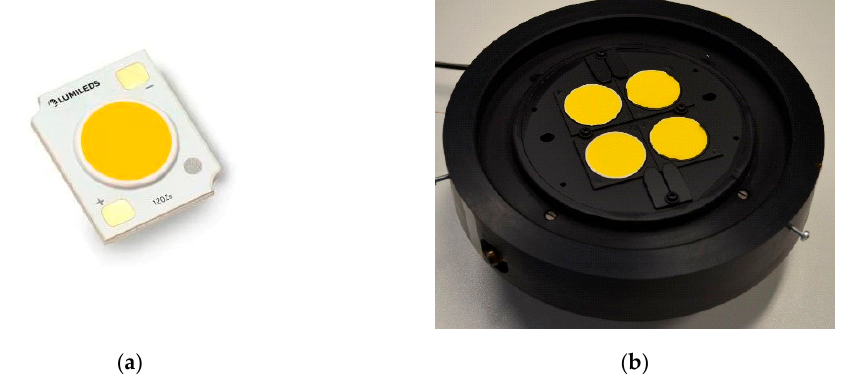
Figure 6. Commercially available CoB LED devices in their unpowered state were also measured as stand-alone phosphor samples: ( a ) A Lumileds 1202 s CoB LED device; ( b ) multiple such CoB LED devices attached to a temperature-controlled stage to be measured as stand-alone phosphor samples.